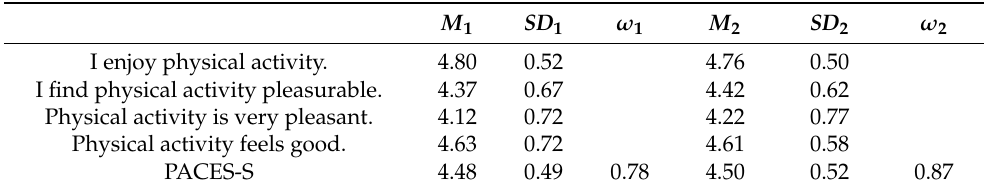
Table 3. Descriptive statistics of Study